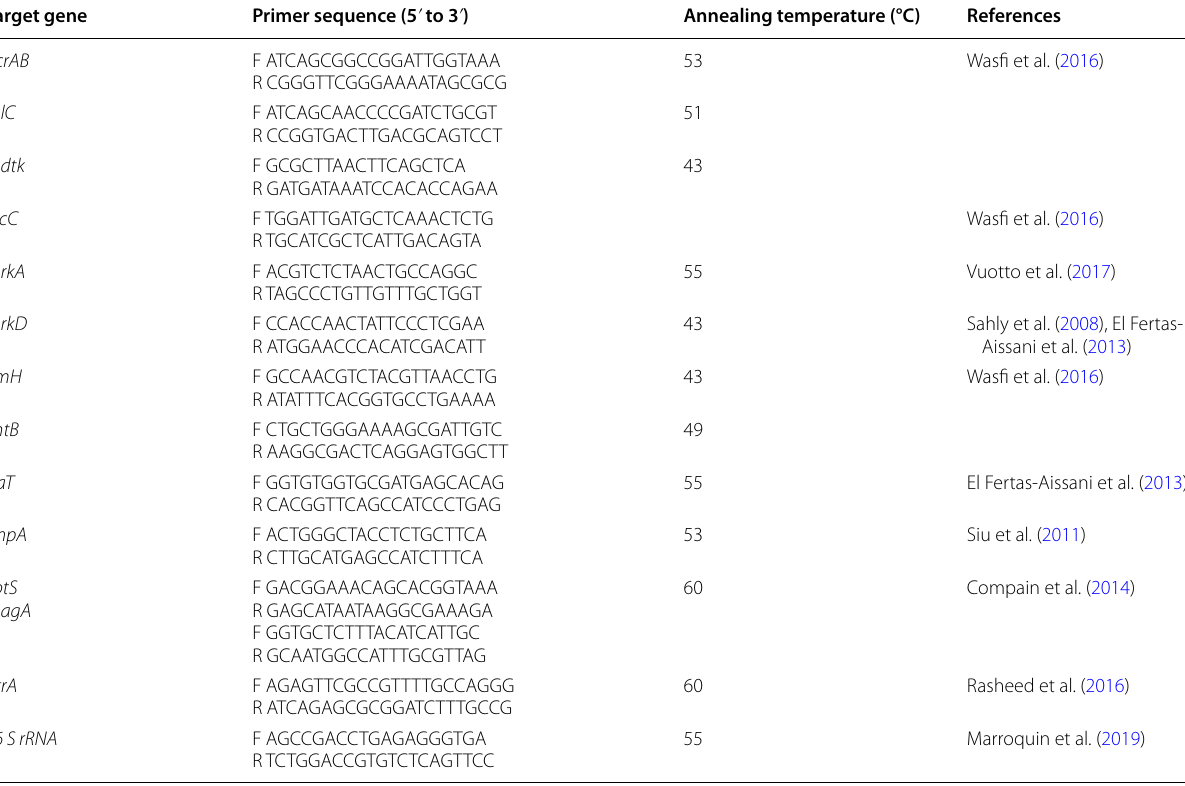
Table 1 The primer sequences of target genes which used in this study Target gene Primer sequence (5 ʹ to 3 ʹ